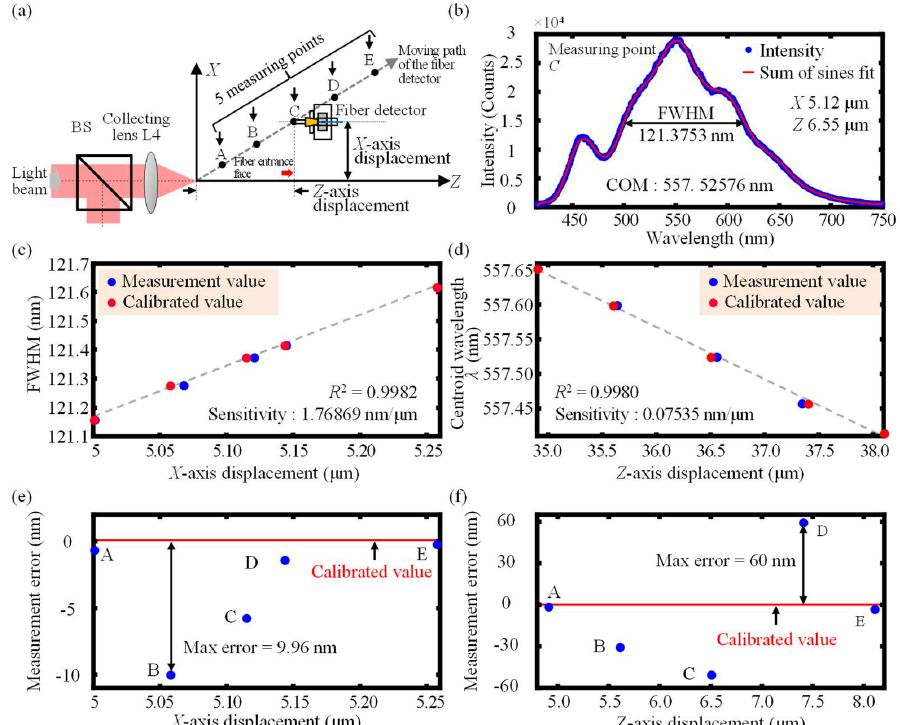
Figure 12. Schematic of ( a ) the moving path of the fiber detector and five randomly selected measuring points A to E. ( b ) Experimental results of the obtained output spectrum of the measuring points C and Experimental results of the simultaneous measurement of ( c ) X - and ( d ) Z -axis displacements together with the corresponding measurement errors of ( e ) X -axis and ( f ) Z -axis for the prototype probe.